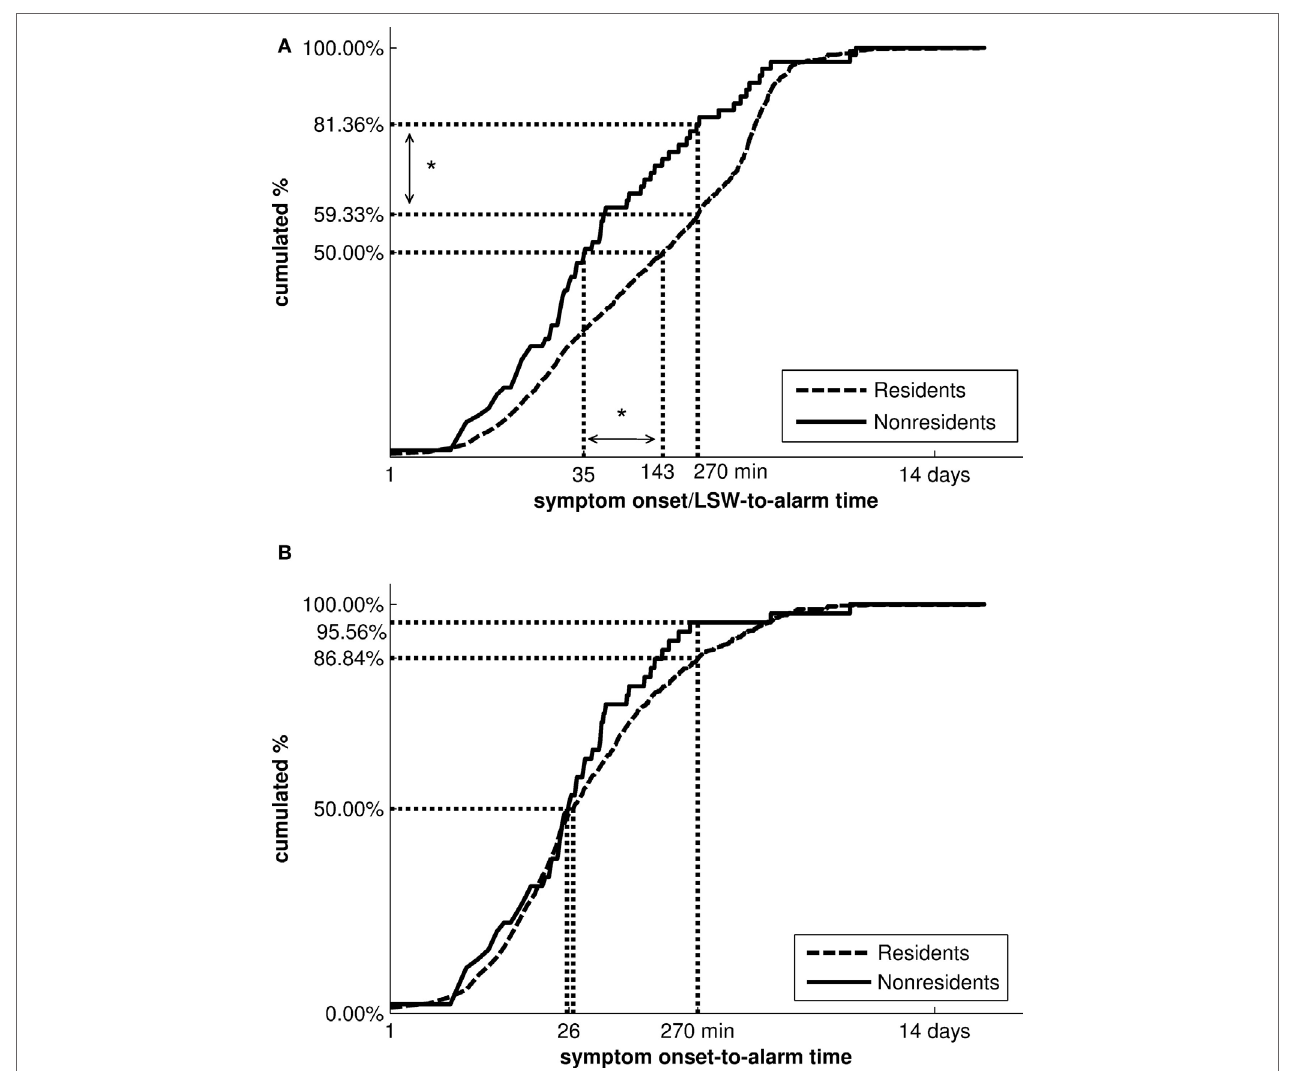
FigUre 3 | Cumulative distributions of symptom onset/LSW-to-alarm times and symptom onset-to-alarm times of non-resident and resident stroke patients. Vertical and horizontal dotted lines visualize the distributions’ median and the proportion of patients with a symptom onset/LSW-to-alarm and symptom onset-to- alarm time of less than 4.5 h. Note the logarithmic time scale on the horizontal axis. (a) The distribution of symptom onset/LSW-to-alarm times was significantly different between non-residents and residents with a diagnosis of stroke after adjustment for confounders (age, modified Rankin Scale Score, National Institutes of Health Stroke Scale score). (B) In patients with known time of symptom onset, no differences in the symptom onset-to-alarm times were observed (* p < 0.05). LSW, last seen